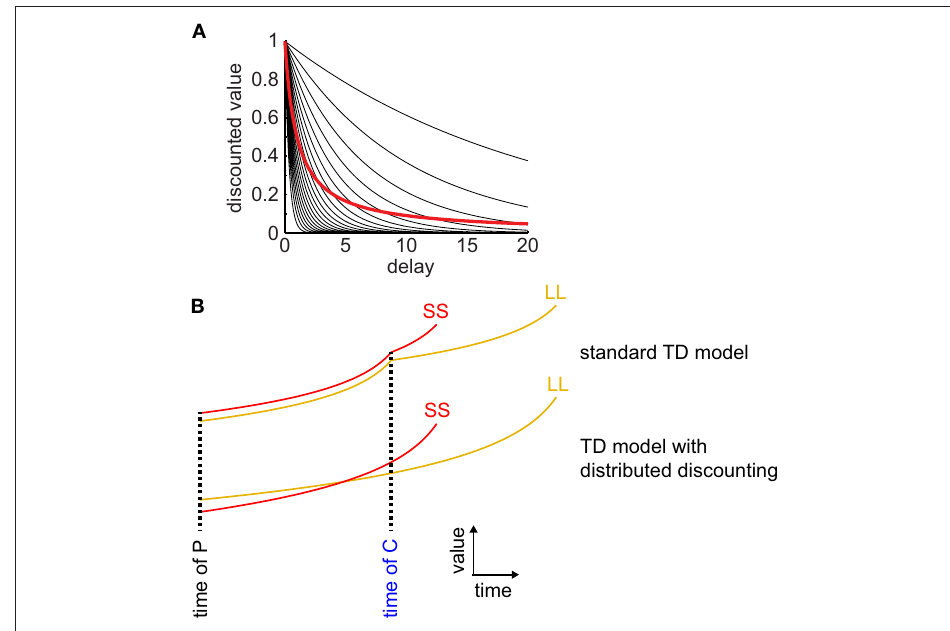
Figure 2 | Distributed discounting enables precommitment in temporal difference learning. (A) Twenty exponential curves with discounting rates spread uniformly between 0 and 1 are shown in black. The average of these curves is shown in red. This average curve closely approximates a hyperbolic function. (B) Standard TD models cannot precommit because, at each state transition, discounting starts over, ensuring that if SS is preferred over LL at the time of C, then it is also preferred at the time of P ( top pair of curves ). When averaging a set of exponential discount curves, discounting is not reset at each state transition, so preferences can reverse between C and P ( bottom pair of curves